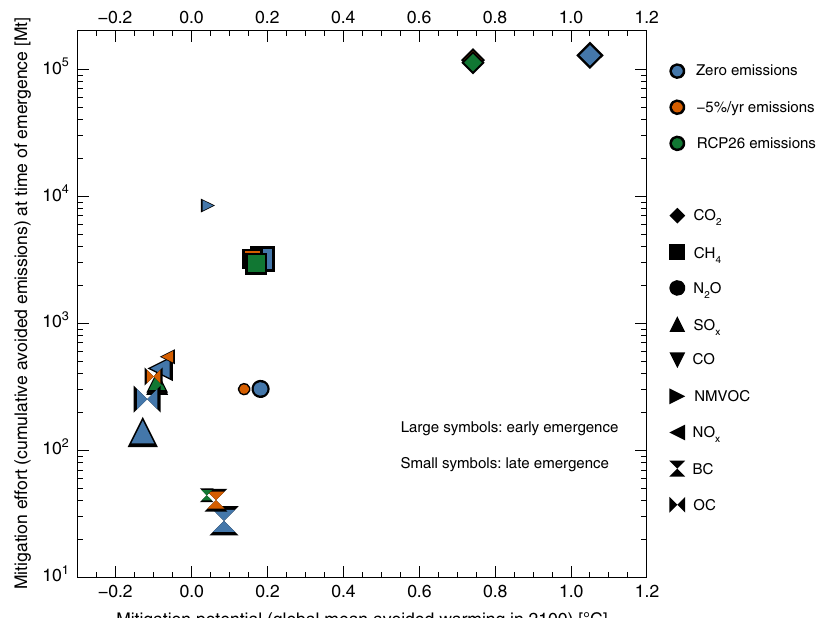
Fig. 5 Potential versus effort for single forcer mitigation. Mitigation potential (avoided temperature increase in 2100) versus mitigation effort, here quanti fi ed through the total mass of mitigated emissions at time-of-emergence. Global mean surface temperature change in 2100 was calculated using MAGICC6. The symbol size scales with time-of-emergence, large symbols indicate early emergence, small symbols later emergence. See Table 3 for time- of-emergence